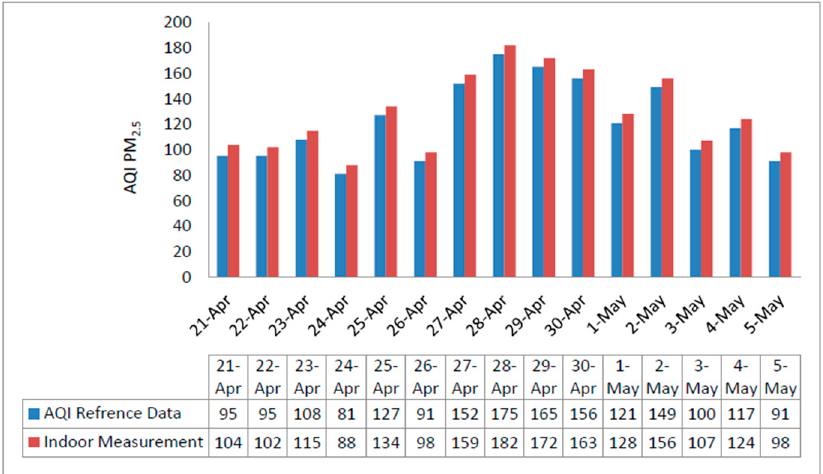
Figure 12. Outdoor measured PM 2.5 AQI compared with official data, from 21 April to 5 May 2018. Figure 13. Outdoor measured PM 2.5 AQI compared with official data, from 21 April to 5 May 2018.